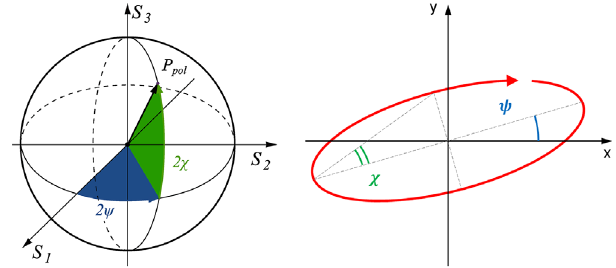
FIG. 13. Poincar´e sphere and polarization